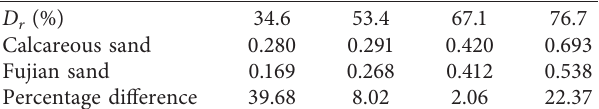
Figure 10: Comparison of cyclic strength of calcareous and Fujian sands. Table 2: Comparison of CRR values of calcareous and Fujian sands.